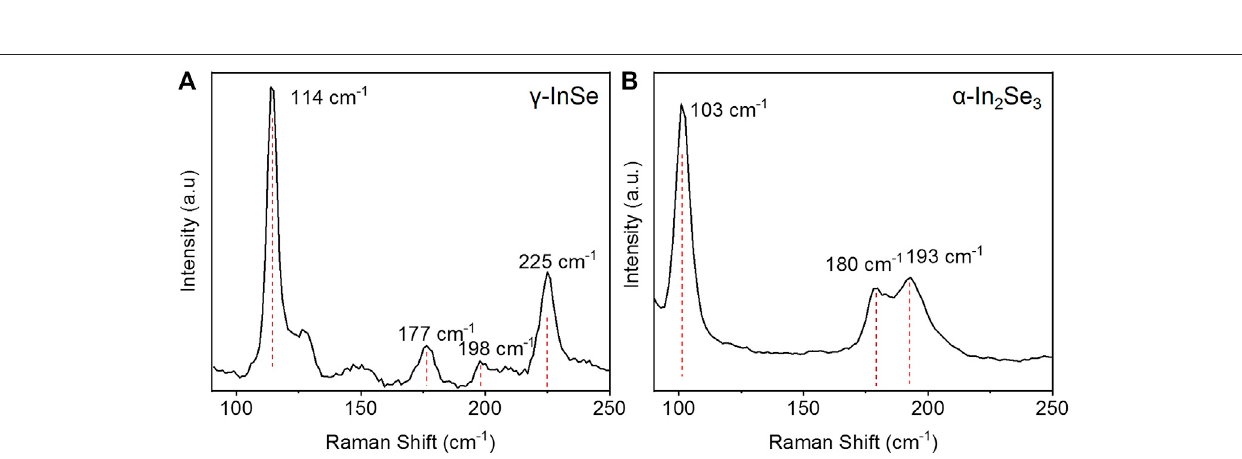
Frontiers in Materials |